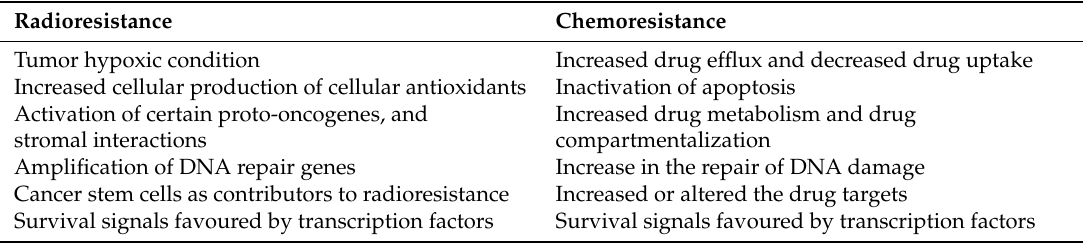
Table 2. Mechanisms by which tumor cells resist radiation and chemotherapeutic drugs.